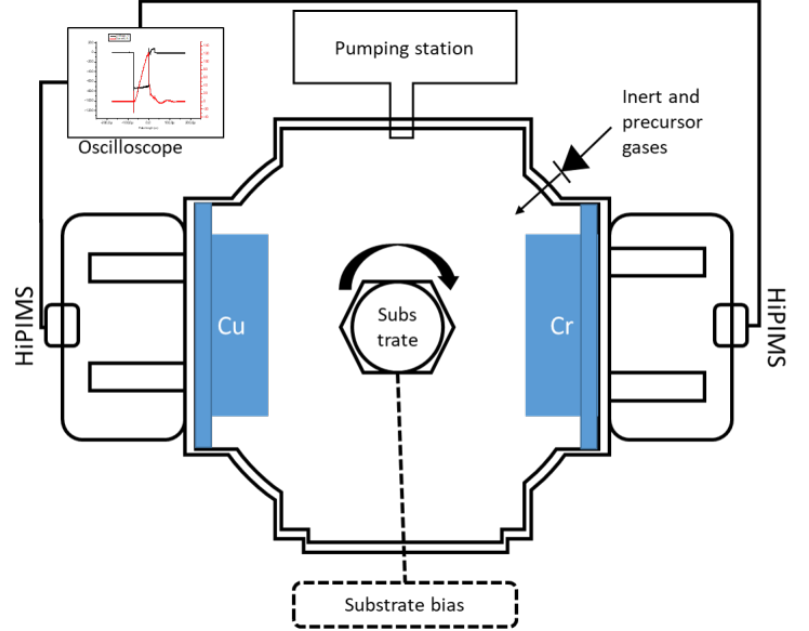
Figure 3. Schematic representation of the dual-cathode (Cu and Cr) HiPIMS process used in this study.